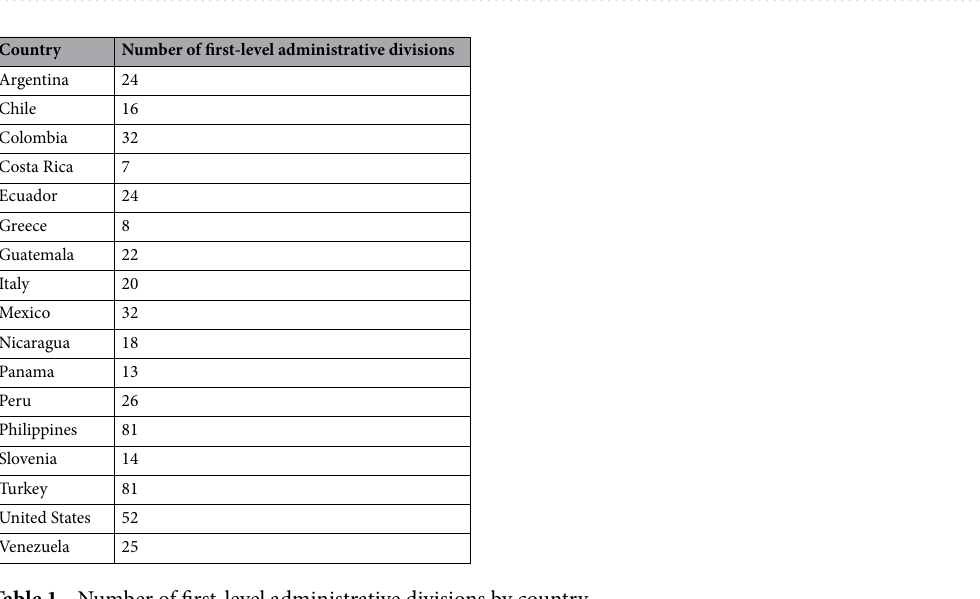
Figure 5. Linear correlation between M 1 and M 2 and Google’s mobility indices vs average data set penetration for the 17 countries under the non-smoothing case. Solid lines are the fits by a beta regression model with logit link function, while dashed lines are 95% confidence intervals on fitted values. R 2 are pseudo coefficients of determination, while the p-values refer to an F-test on the regression model, which tests whether the model fits significantly better than a model with only the constant term. Each label is a country. Overlapping labels are in different colours. All correlations between M 2 and Google’s “Workplaces” index are negative but they are modelled without sign to keep consistency with Fig. 3 and to allow beta regression.